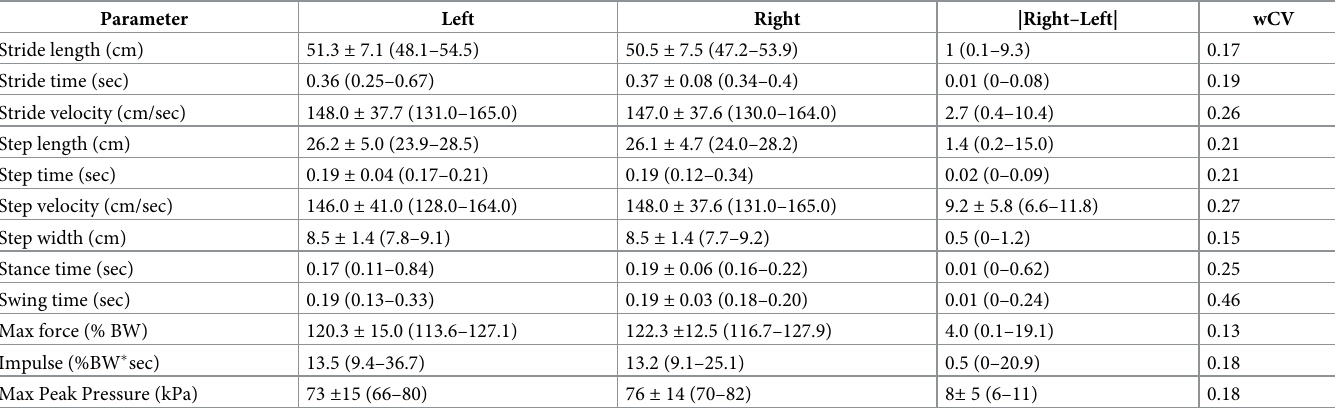
Table 2. Experiment 1: Normal ducks gait analysis continued.